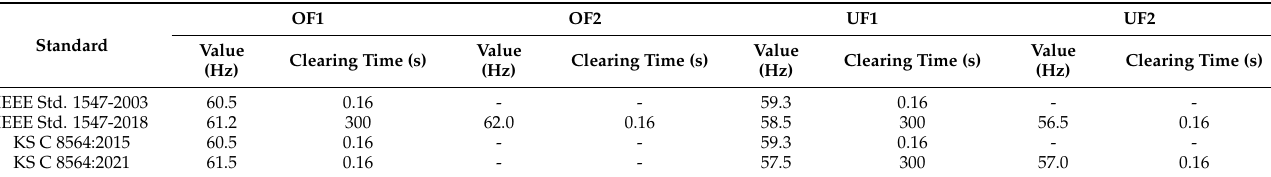
Table 2. DG response to abnormal frequency by